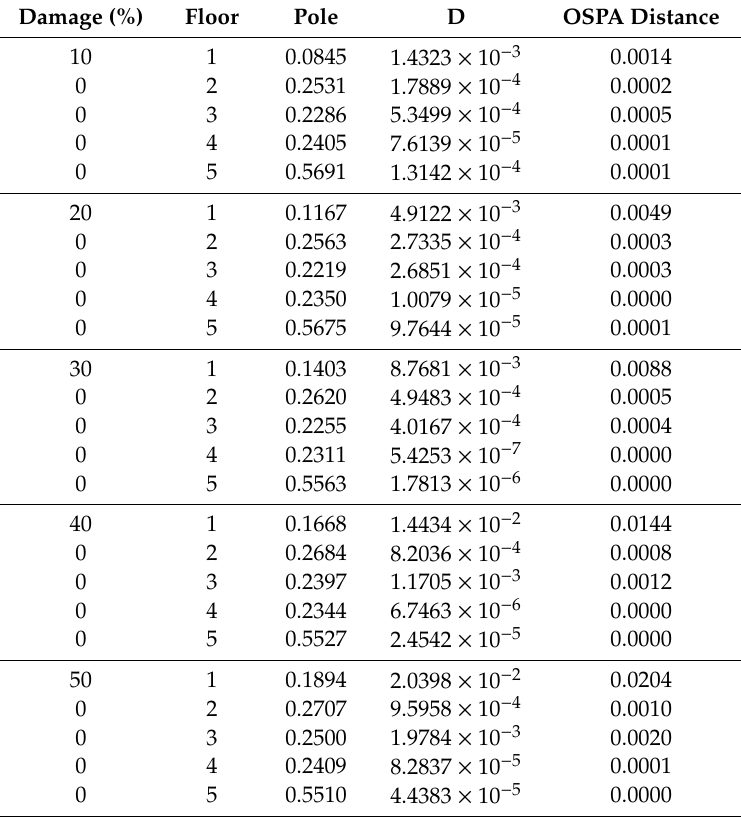
Table 1. OSPA distance and the corresponding parameters for the case of damage occurring on the first floor (mutually correlated white noises inputs, 5% noise, autoregressive model, data length = 4000, AR order = 1, OSPA.p = 2, Assignment = 1). Damage (%) Floor Pole D